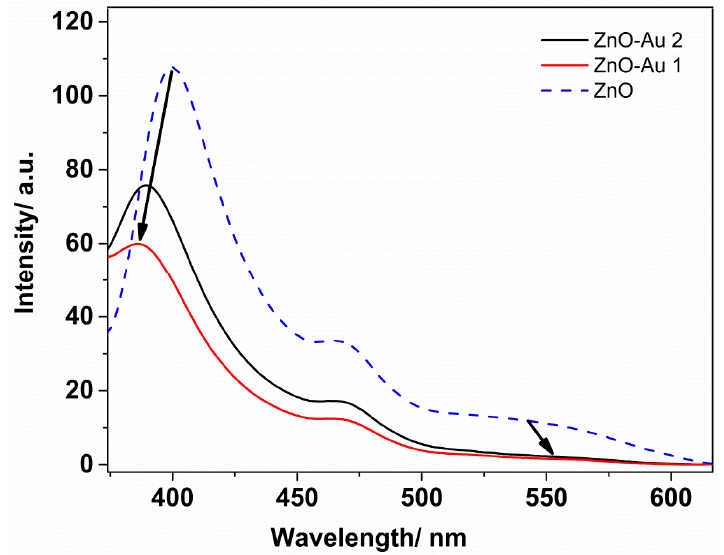
Figure 8. Fluorescence spectra characteristic of the ZnO nanoparticles and the ZnO-Au nanocom- posites. Excitation: 340 nm.